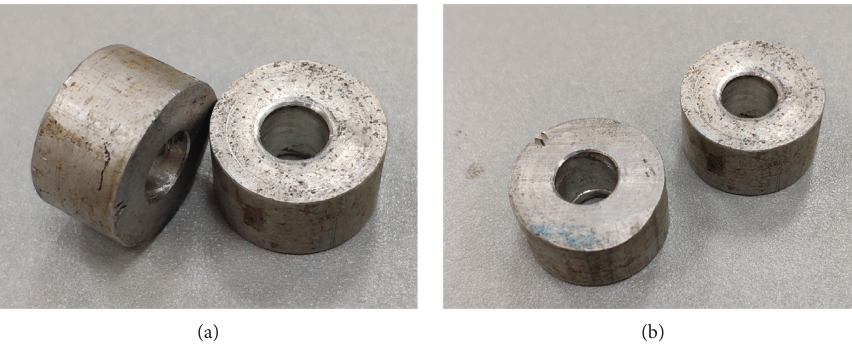
Figure 13: The experimental results of the cushion block.